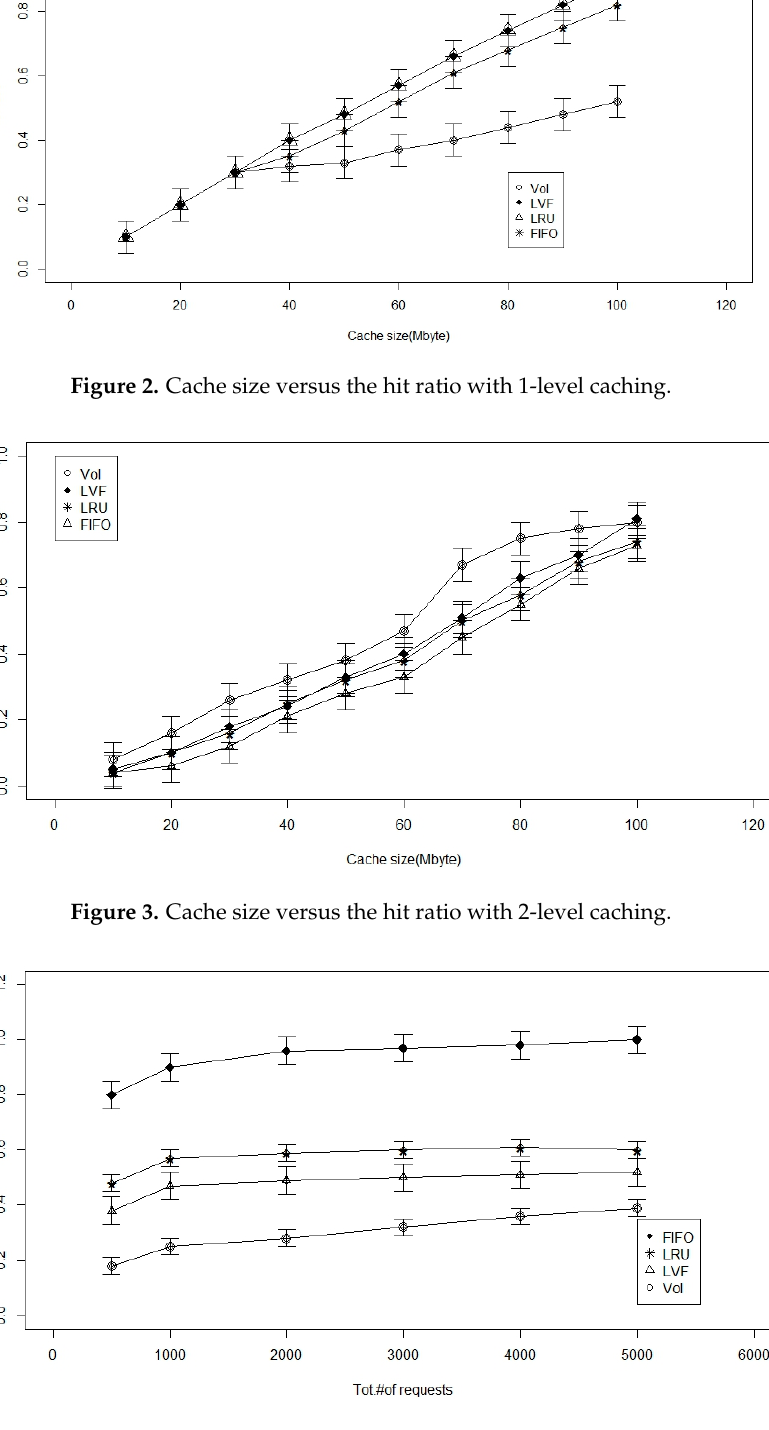
Figure 4. Total number of requests versus the hit ratio with 1-level caching.